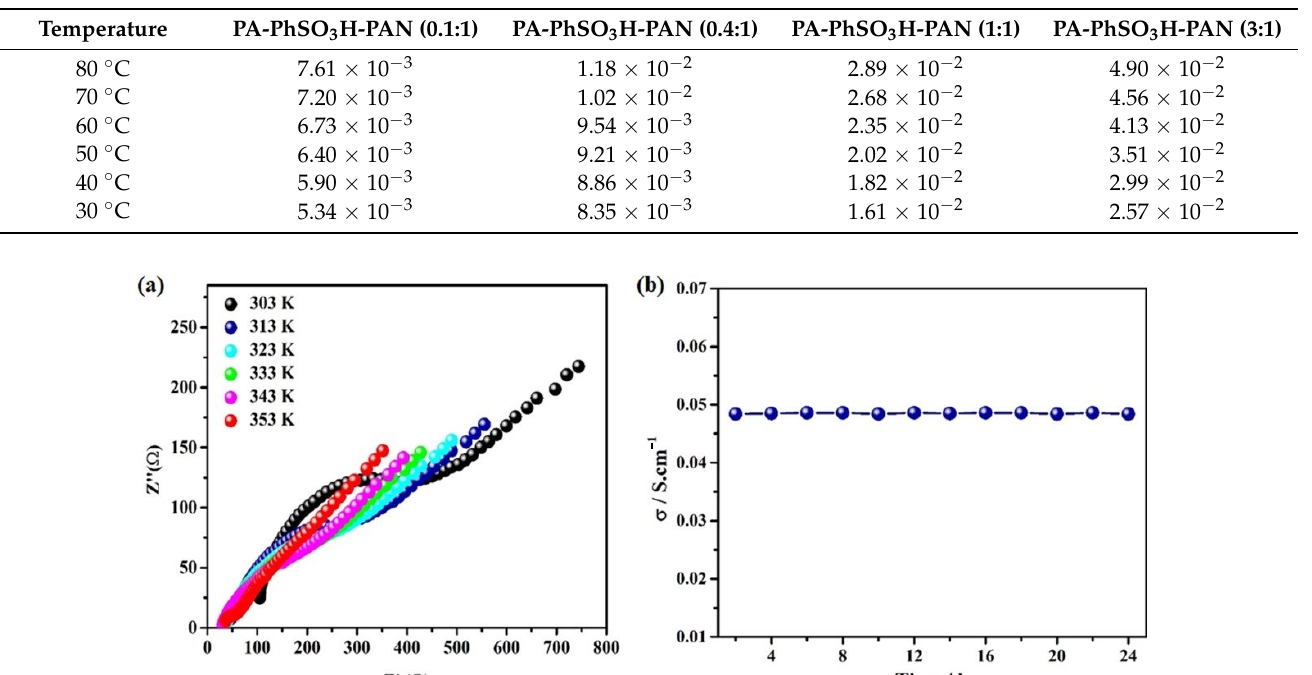
Table 3. Temperature-dependent proton conductivities (S · cm − 1 ) of the fabricated matrix-mixed membranes with different ratios at 98% RH.